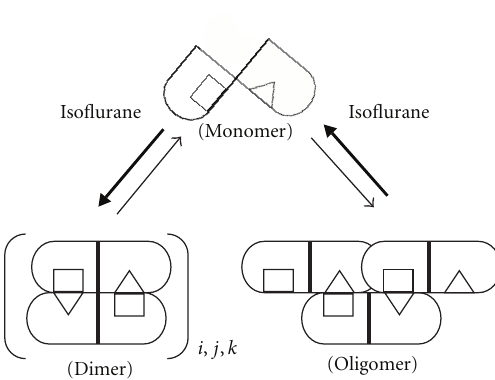
Figure 6: Target HSA species that are modified by MG. Our model suggests that the HSA dimer represents an isologous association of twofold symmetry with complementary binding sites indicated by squares and triangles. The nucleus for further higher-order HSA oligomerization may be a trimer [24] with a proposed screw symmetry, forming a heterologous association. While isoflurane promotes dimerization [5], it may also a ff ect the distribution of HSA dimer subpopulations (indicated by italicized subscripts: i, j, and k ). Intra- and intermolecular crosslinking by MG (as well as surface residue acetylation) may be influenced by subunit interaction and lead to cellular responses conferring